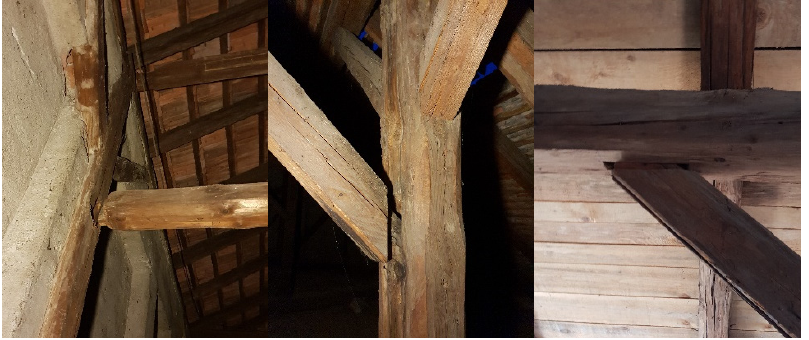
Figure 6. Damages to the timber roof structure are due to a lack of (out of plane) bracing system. (Photo credit: Jure Barbali ć ). Figure 7. Damages to the timber roof structure are due to the improper design of carpentry com- pression joints. (Photo credit: Jure Barbali ć ).